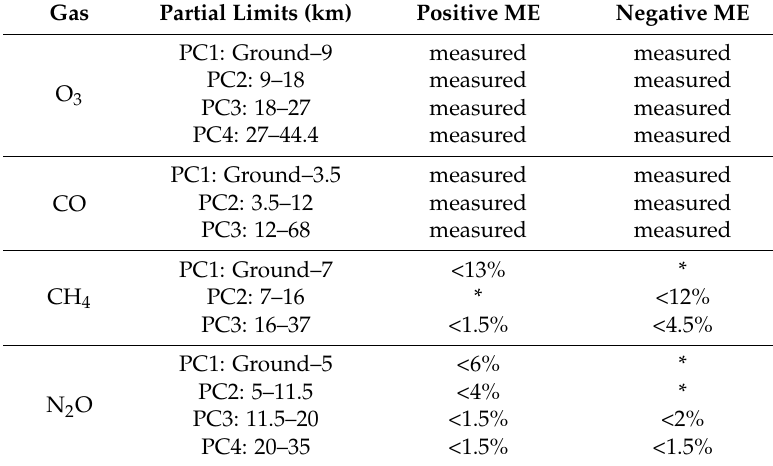
Table 4. Recommendations for limiting the fractional difference in the partial columns of all gases within 2%.